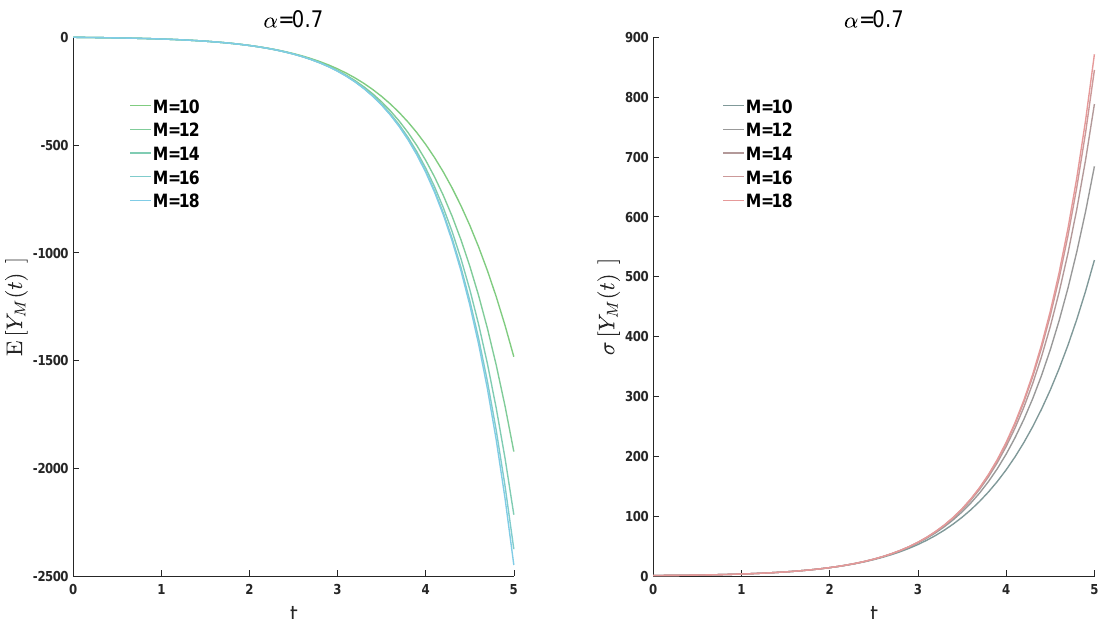
Figure 3 Approximations of the mean (left) and the standard deviation (right) of the solution SP to the random IVP (2) with α = 0 . 7, λ = 5 / 4, E [ b 0 ] = E [ c ] = − 1 and V [ b 0 ] = V [ c ] = 1 / 4 using different orders of truncations M over the time intervals [ 0 , 5 ]